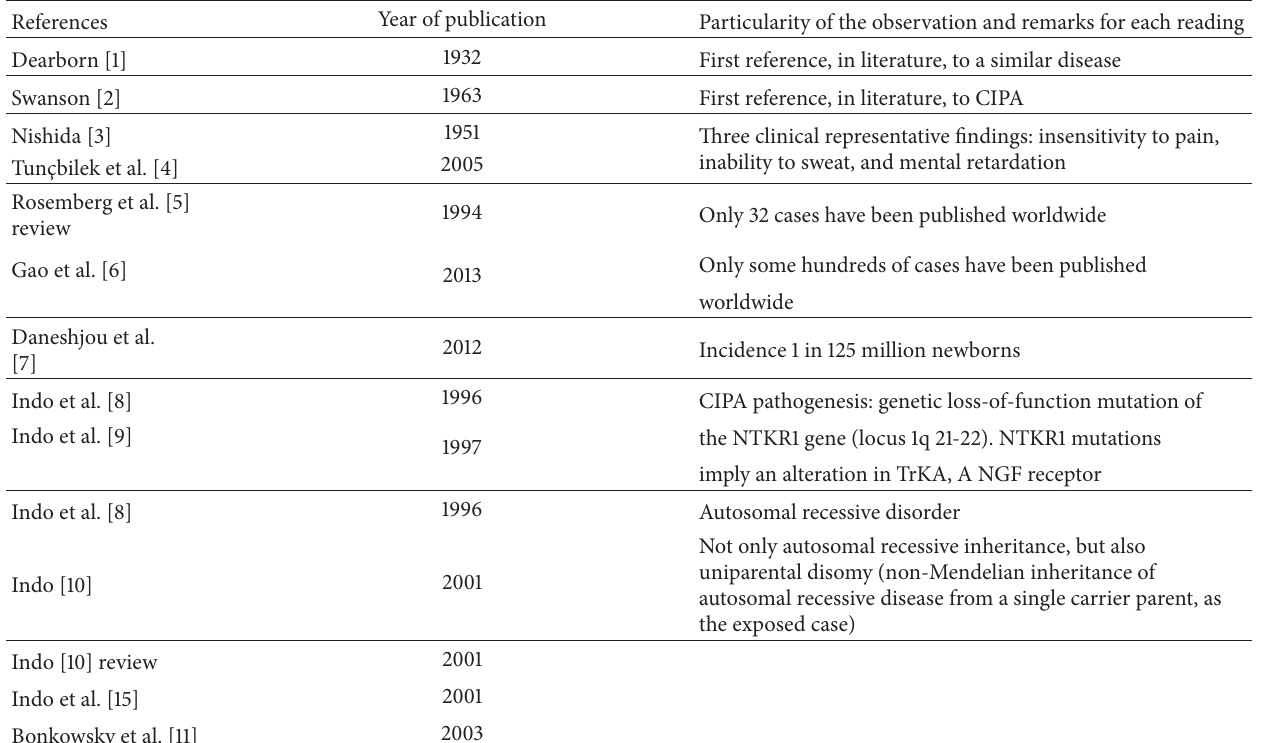
Table 1: Thorough review of the PubMed literature on CIPA and associated medical conditions mentioned in this paper was